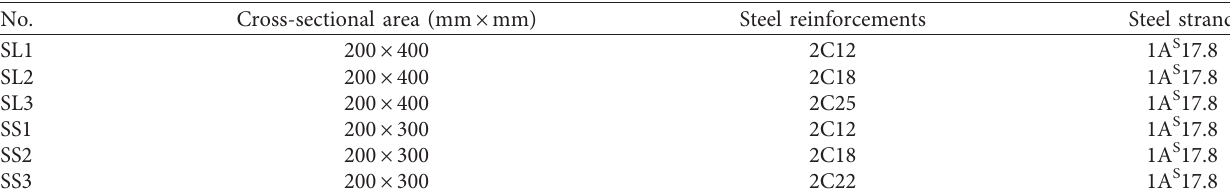
Figure 1: The reinforcement of specimens: (a) SS beams; (b) SL beams. Table 1: Properties of specimens.